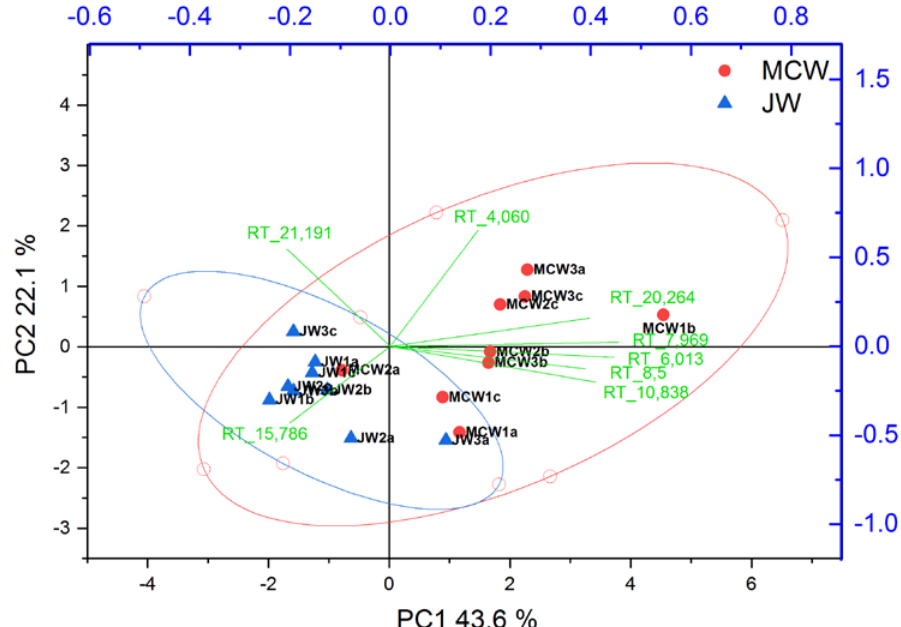
Figure 2. Principal component analysis (PCA) of macerated wines performed on the area of 8 volatile constituents statistically different from the two sites based on ANOVA and p -value < 0.05. The six macerated wines 1,2,3 originating from MC (red circle) and J (blue triangle) and analyzed in technical triplicates a, b, c. Red and blue ellipses correspond to the groups of macerated wines for MC and J, respectively with an interval of confidence of 95%. Loadings of the PCA are plotted in green and represent the eight molecular features associated with their RT (retention times) obtained in the chromatograms.